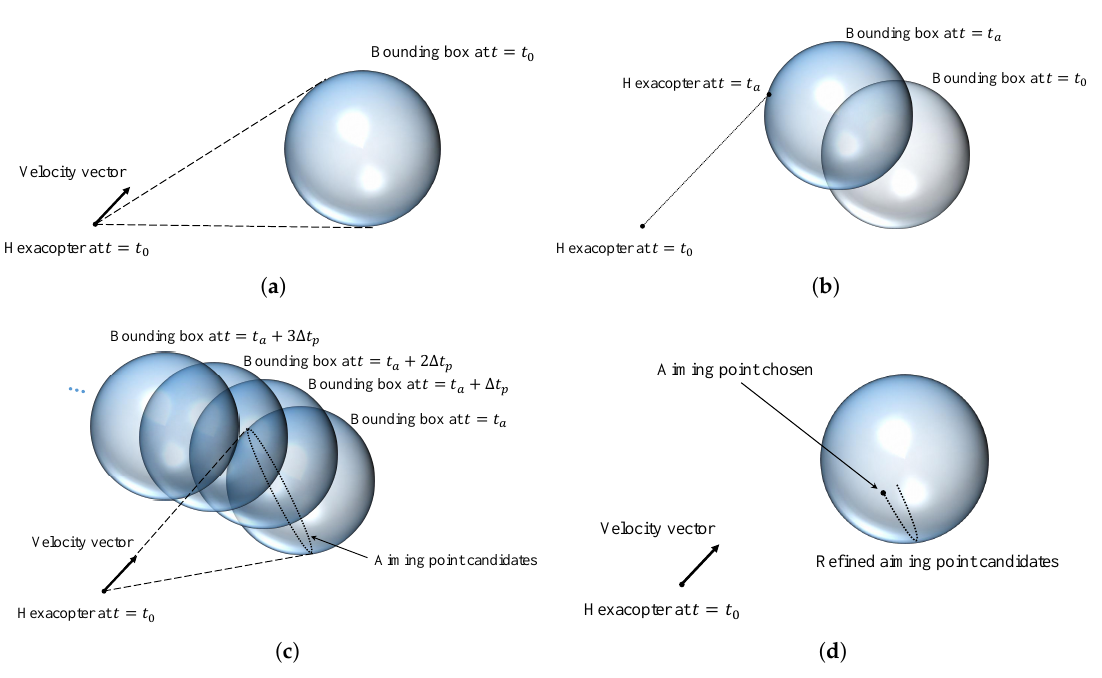
Figure 4. Collision avoidance strategy using predicted trajectory of obstacle: ( a ) velocity vector outside the collision cone at t = t 0 , ( b ) collision at t = t a , ( c ) pruning process, and ( d ) final aiming point